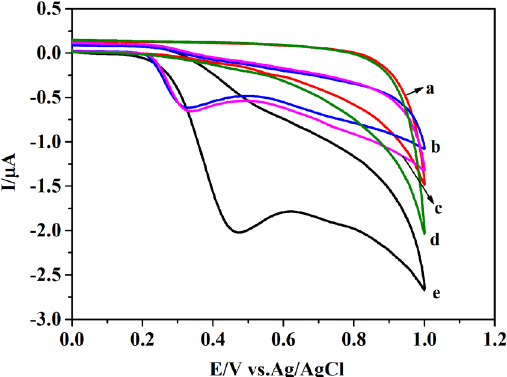
Figure 2. CV curves of blank urine after solid phase extraction (SPE) (a) Spiked MNs (10.0 mg/L) in mixed blank urine after SPE (b) Spiked MNs (10.0 mg/L) in PBS (c) 100 mM PBS (pH8.0) (d) Blank urine (e).